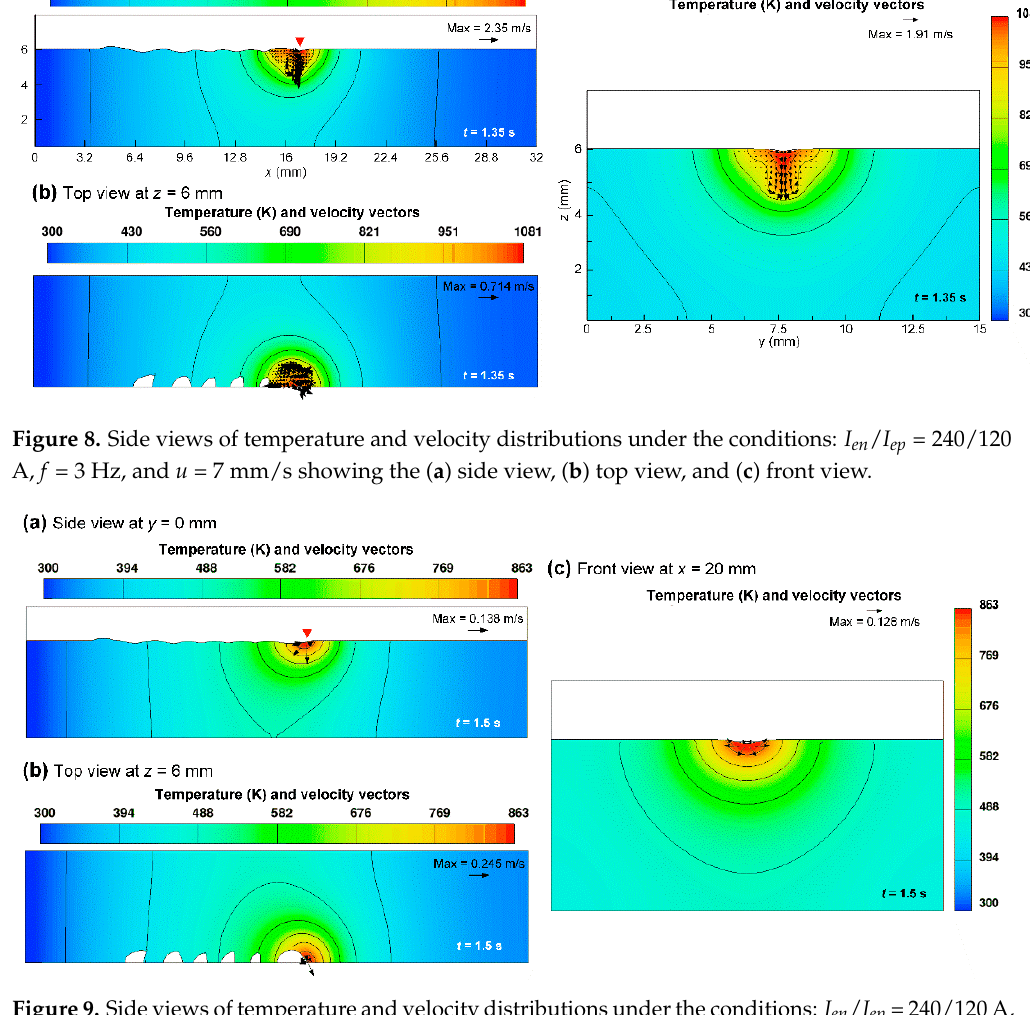
Figure 9. Side views of temperature and velocity distributions under the conditions: I en / I ep = 240/120 A, f = 3 Hz, and u = 7 mm/s showing the ( a ) side view, ( b ) top view, and ( c ) front view.